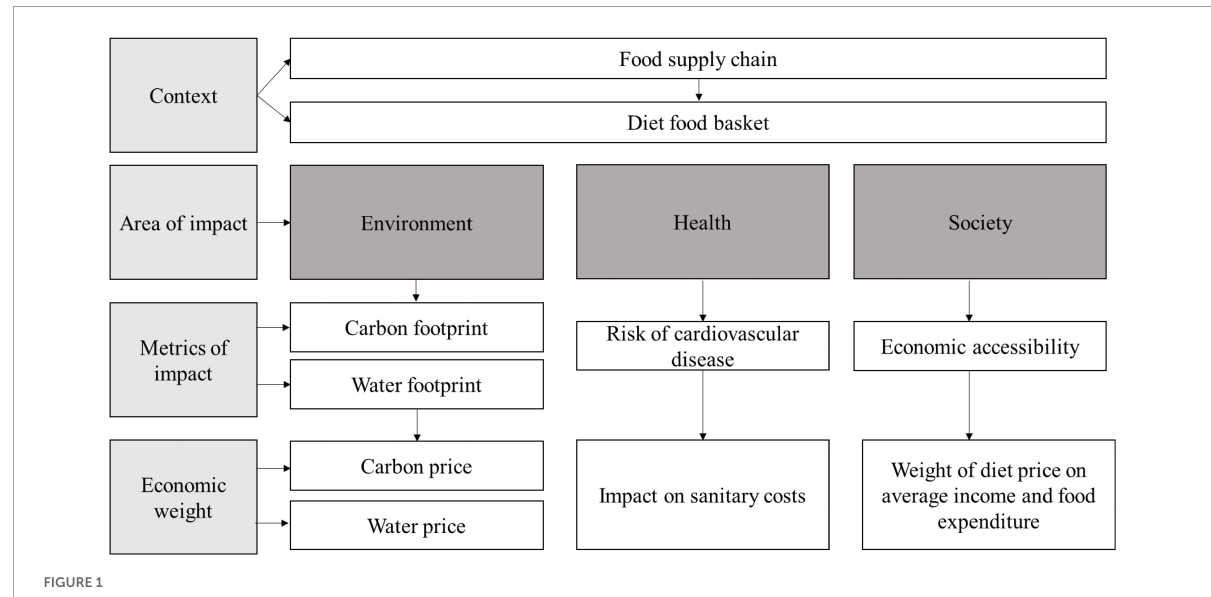
FIGURE1 TCA model (Source: